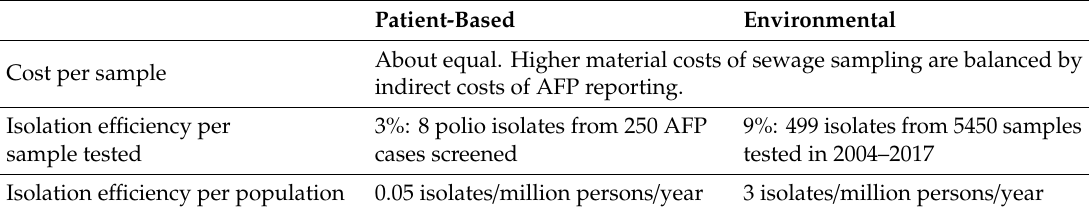
Table 3. Relative cost and e ffi ciency of poliovirus and enterovirus